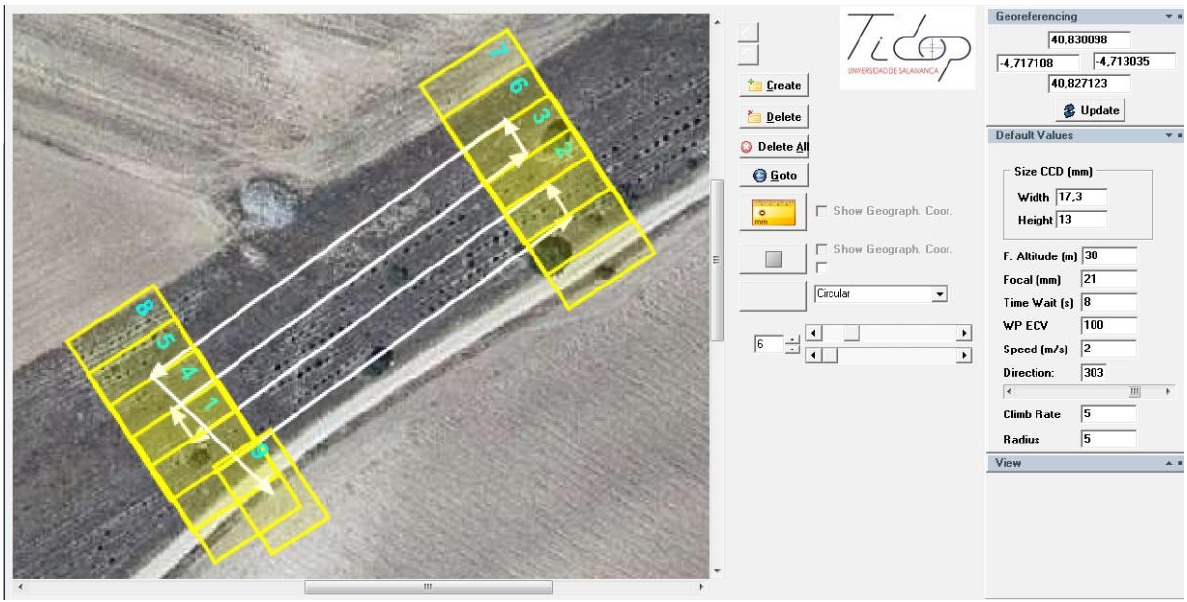
Figure 4. Photogrammetric flight planning using an orthoimage of the study